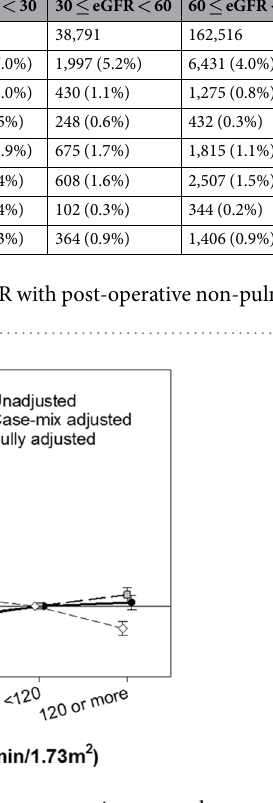
Figure 4. Estimated GFR and risk of post-operative non-pulmonary infectious complications. Multivariable logistic regression analyses were conducted to examine the association of estimated GFR with post-operative non-pulmonary infectious complications among 425,213 patients who underwent laparoscopic surgery (2005– 2013) with three levels of adjustment. Points and lines represent the point estimates and 95% CIs,